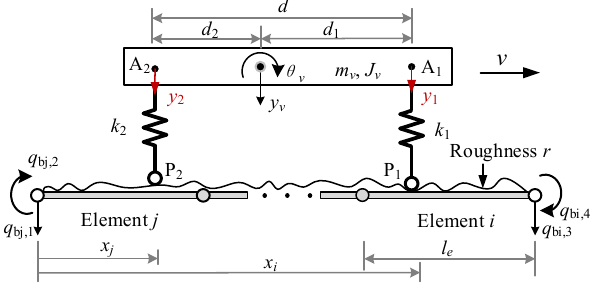
Figure 4. Two-axle vehicle–bridge interaction element.